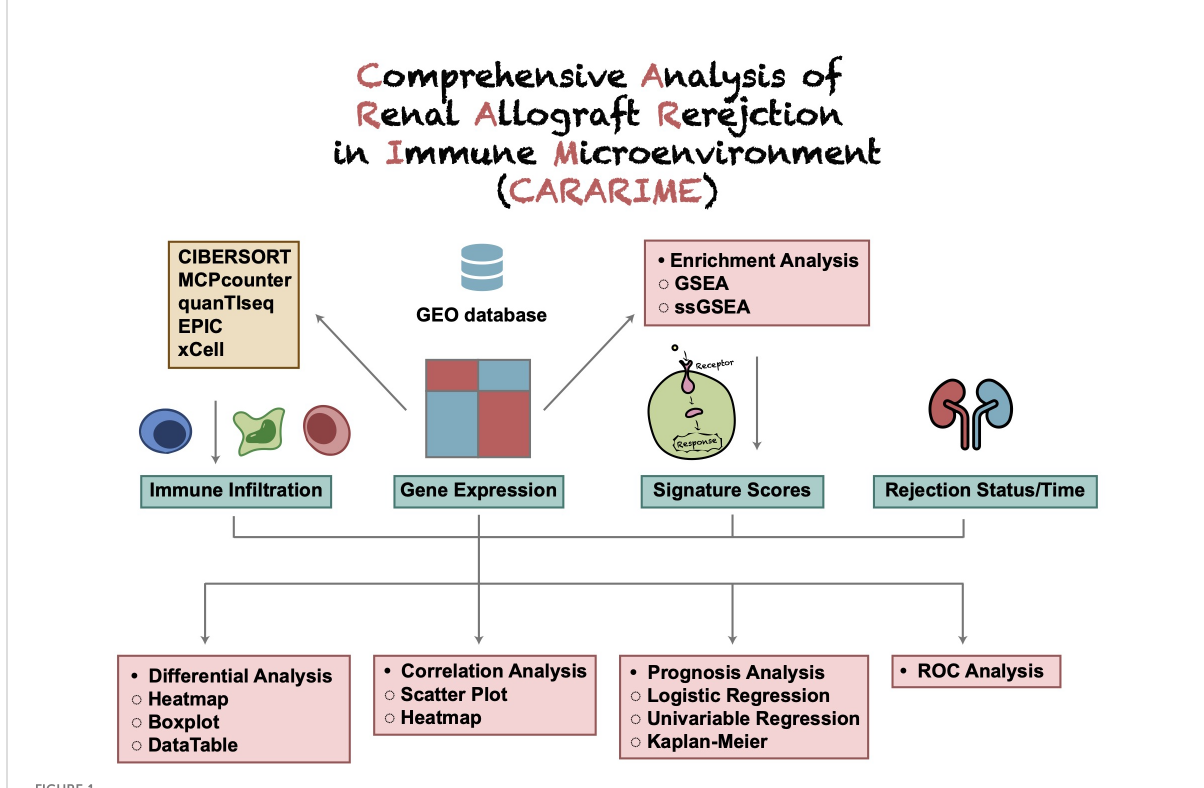
FIGURE 1 The fl owchart of CARARIME